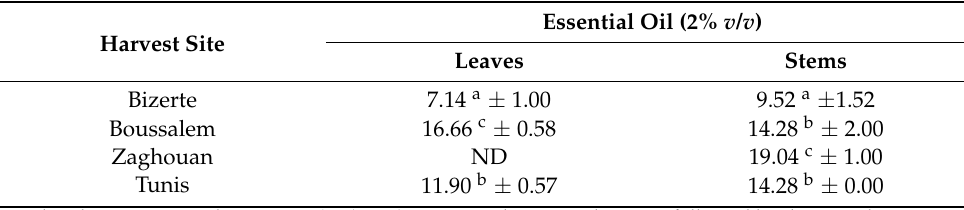
Table 7. Toxicity (% of mortality) of essential oils from M. vulgare against Artemia salina * . Harvest Site